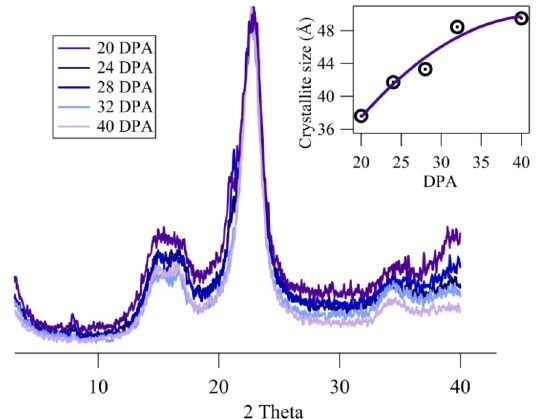
Figure 4. XRD spectra of cotton fibers harvested at different developmental time